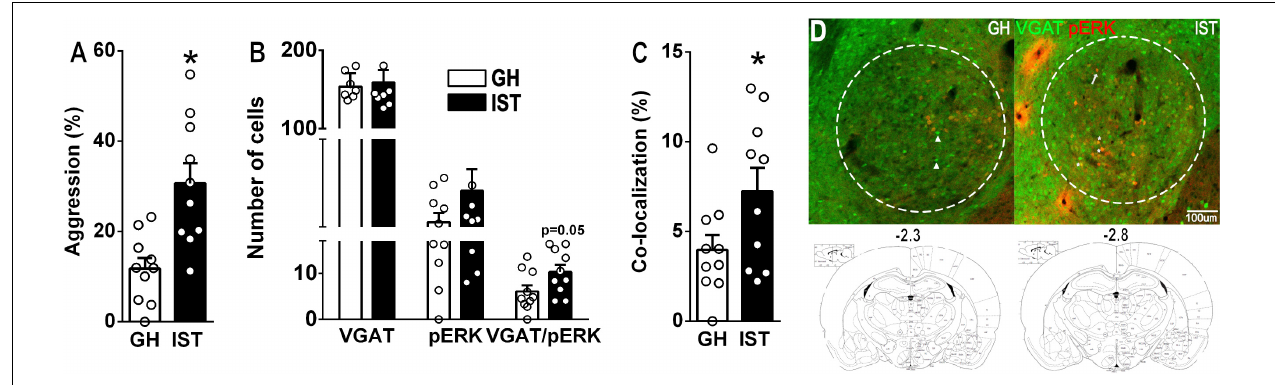
FIGURE 1 | Social isolation and aggression-training (IST, black bars) exacerbate the percentage of time group-housed (GH, white bars) female Venus-VGAT rats spent on aggression (sum of time spent on keep down, threat, offensive grooming, and attacking/total time × 100%) in a 10-min long FIT (A) . In IST females we found an increased number of cells showing co-localization of VGAT (green) and pERK (red) in the central amygdala (B–D) . (D) Maximal z -projection of VGAT (green) and pERK (red). Scale bar 100 µ m. Data are presented as mean + s.e.m. * p < 0.05 vs. GH. Arrow-heads, arrows, and stars to exemplify VGAT-, pERK-, and VGAT-pERK-positive cells,